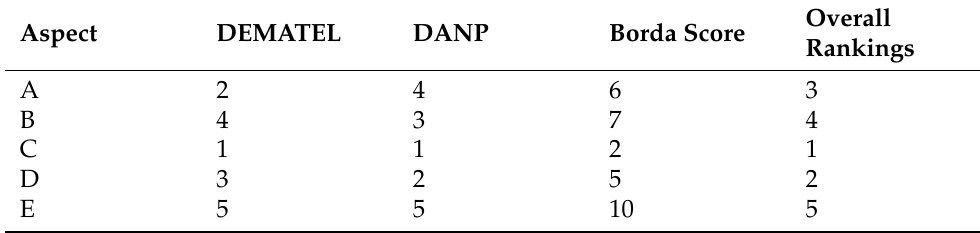
Table 3. The rankings of DEMATEL and